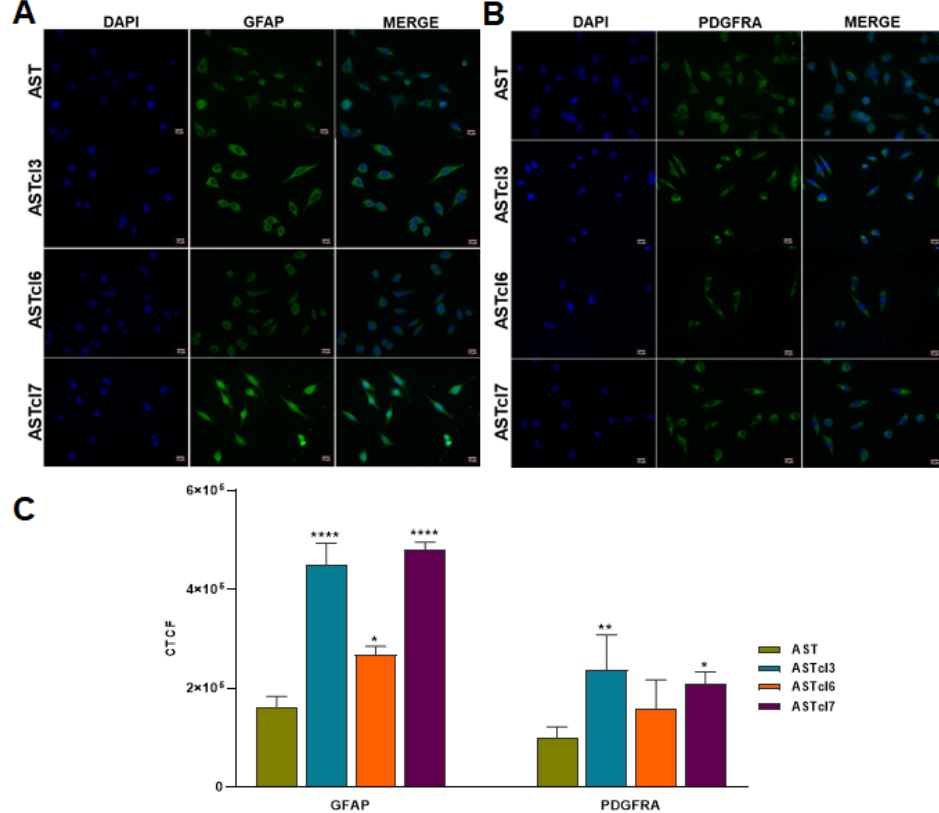
Figure 8. Immunofluorescence analysis in primary astrocytes and derived clones: ( A ) Immunofluorescence staining for GFAP (green) and nuclei (DAPI; blue). ( B ) Immunofluorescence staining for PDGFRA (green) and nuclei (DAPI; blue). ( C ) Quantification of GFAP and PDGFRA staining in primary astrocytes and clones derived from deadhesion blocking cycles (ASTcl3, ASTcl6, and ASTcl7). CTCF: corrected total cell fluorescence. Magnification of 40×, scale bar = 10 μ m. Statistically significant differences in each clone compared to primary astrocytes are represented by asterisks: * p < 0.05, ** p < 0.01, and **** p < 0.0001.